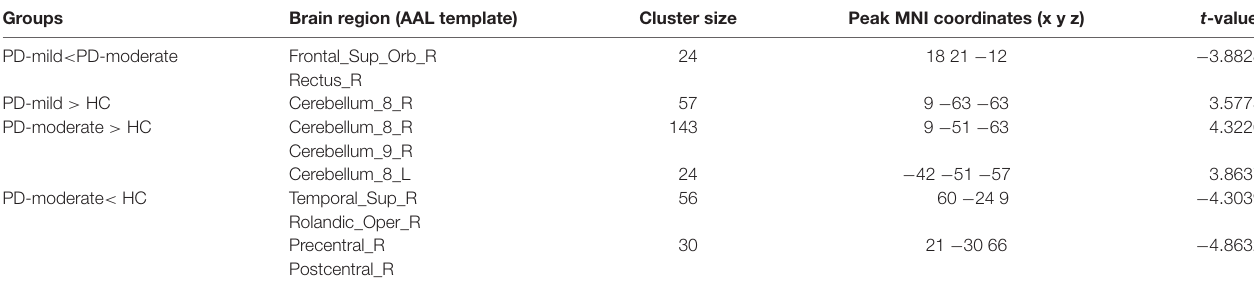
TABLE 2 | Brain regions showing significant ReHo differences between paired groups from the PD-mild, PD-moderate, and HC groupings. Groups Brain region (AAL template)